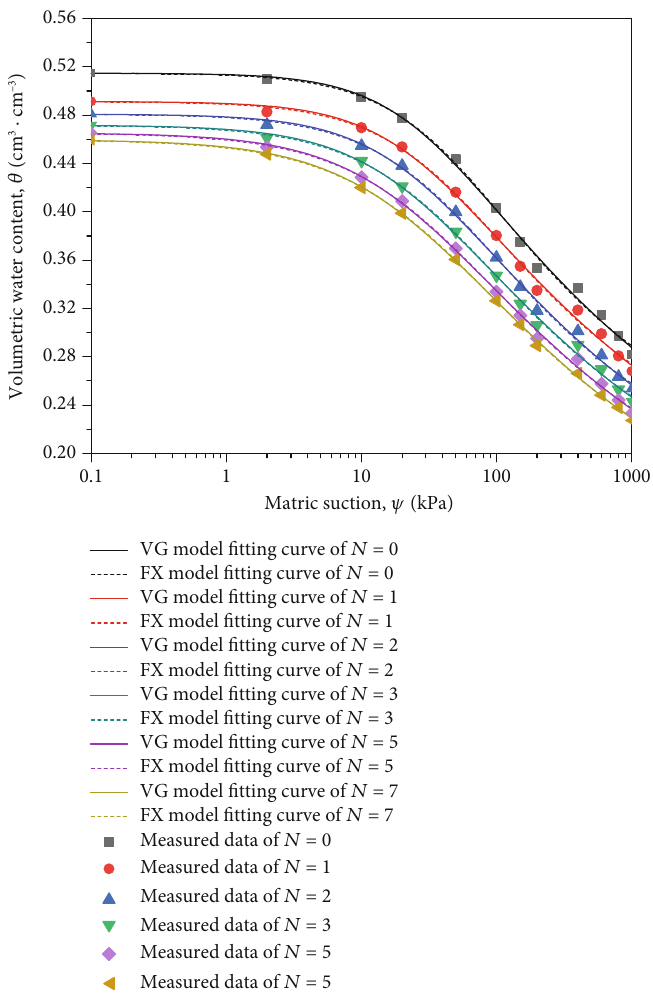
VG model fitting curve of N = 0 FX model fitting curve of N = 0 VG model fitting curve of N = 1 FX model fitting curve of N = 1 VG model fitting curve of N = 2 FX model fitting curve of N = 2 VG model fitting curve of N = 3 FX model fitting curve of N = 3 VG model fitting curve of N = 5 FX model fitting curve of N = 5 VG model fitting curve of N = 7 FX model fitting curve of N = 7